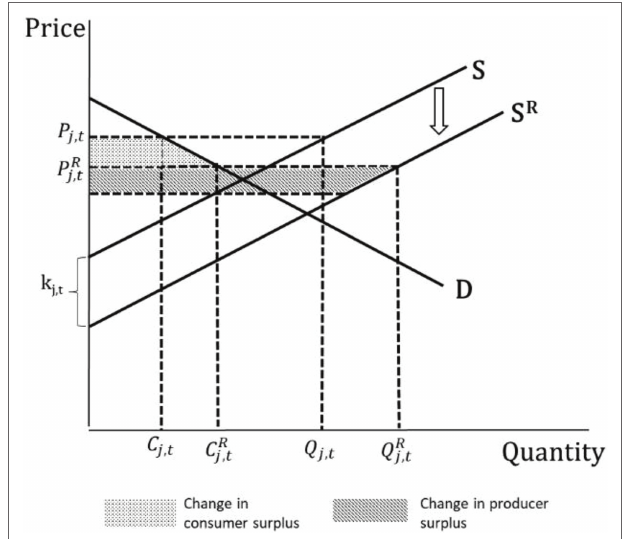
FIGURE 1 | Size and distribution of research benefits. Source : Authors’